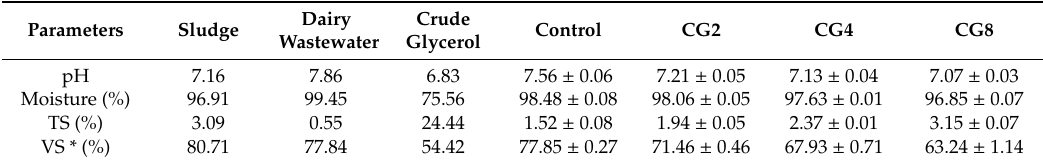
Table 2. Characteristics of feedstock for anaerobic